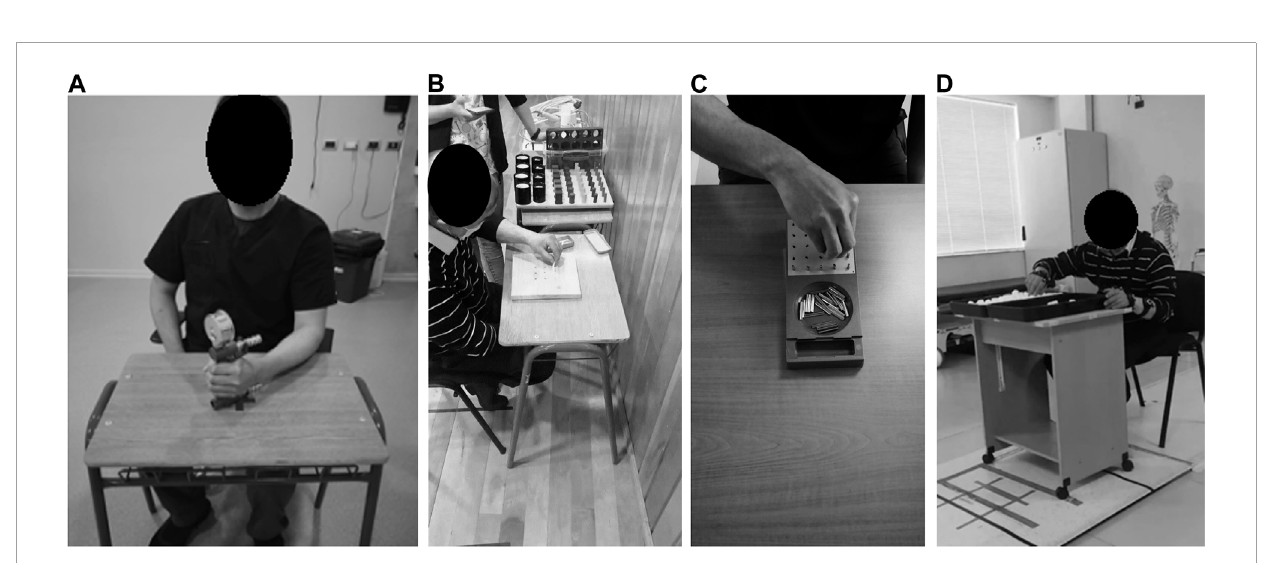
FIGURE 5 Participants performing manual function tests: (A) Grip dynamometry, (B) 9-HPT, (C) GPT and (D) BBT.